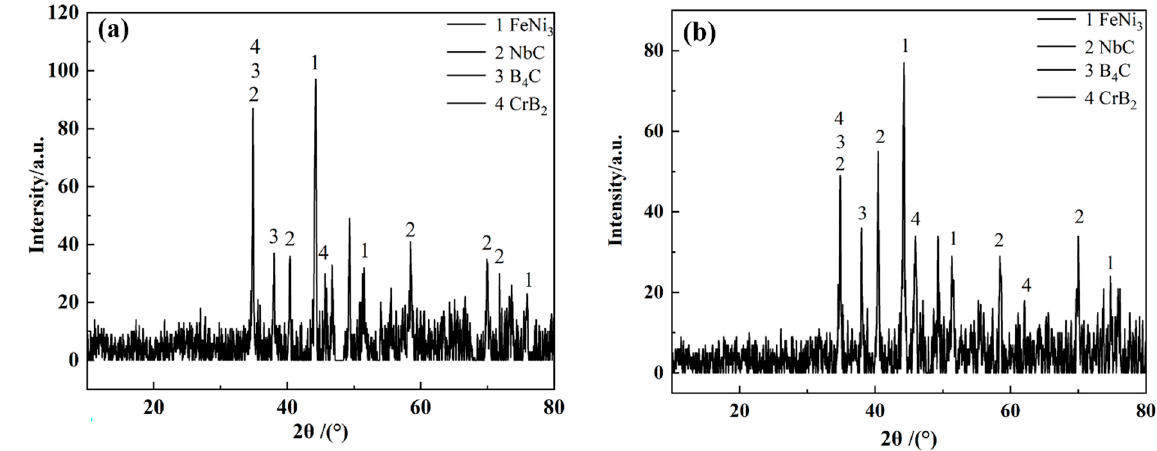
Figure 3. XRD patterns of coatings: ( a ) with and ( b ) without ultrasonic vibrations.